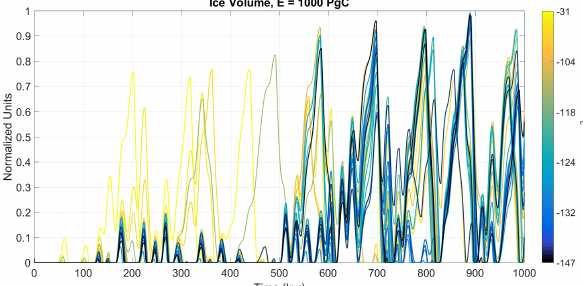
Figure 8. Ice volume time series for each solution in Accepted for the intermediate-emissions scenario ( E = 1000PgC). Each so- lution is coloured according to its corresponding K